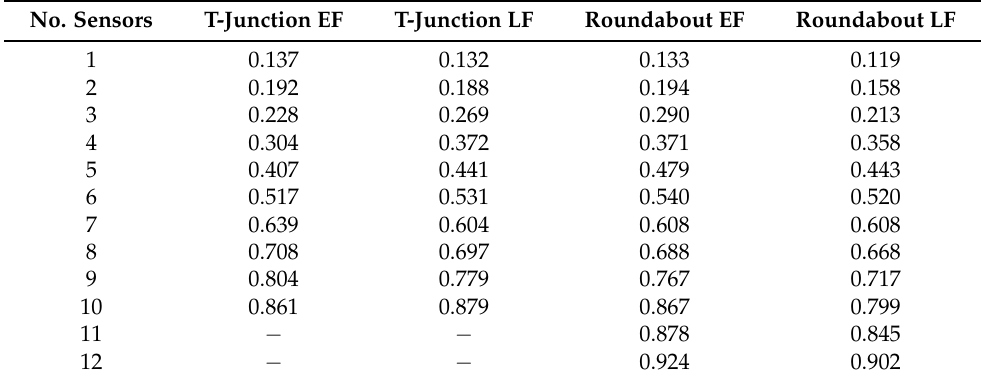
Table 5. Comparative performance analysis considering the AVOD model and various numbers of the active sensors.